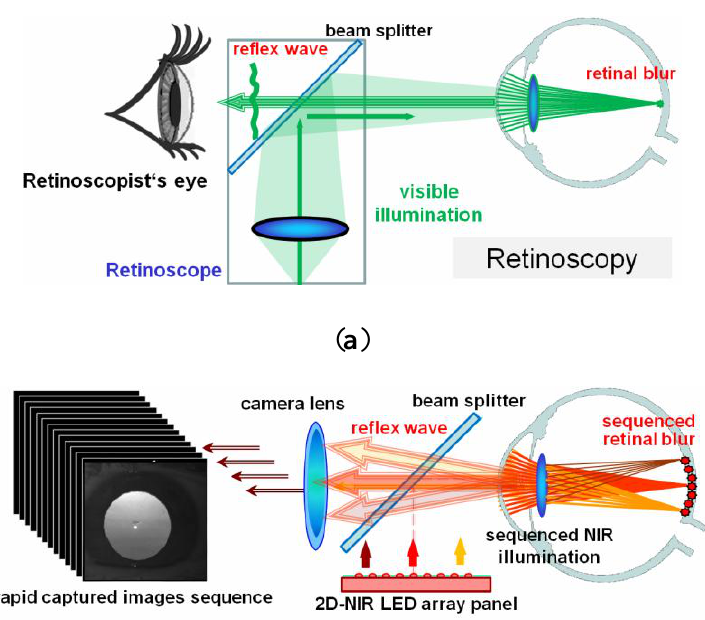
Figure 1. Comparison of optical arrangements (not scaled) in ( a ) retinoscope, and ( b ) infrared retinoscope using multi-eccentric-meridian photorefraction